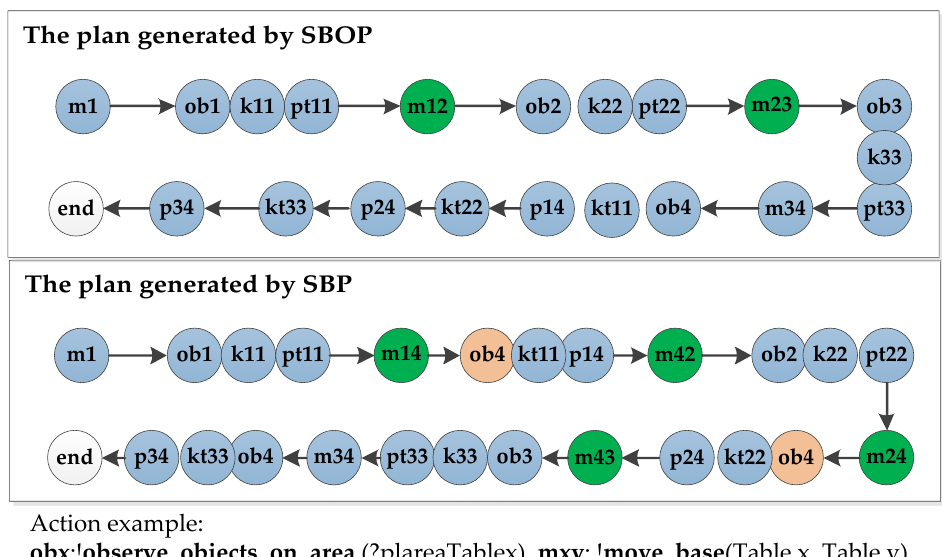
Figure 8. The action sequences generated by SBOP and SBP. The actions in blue represent the same components among the two plans; the actions in orange represent components in the SBP-generated plan but removed in the SBOP-generated plan; the actions in green represent the merged components in the SBP-generated plan compared with the SBOP-generated plan.